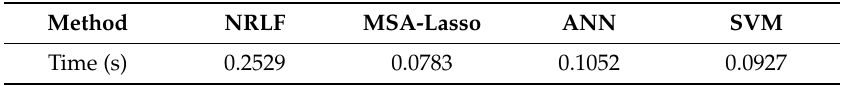
Table 5. Comparison of computation times of a 14-bus system. NRLF: Newton–Raphson load